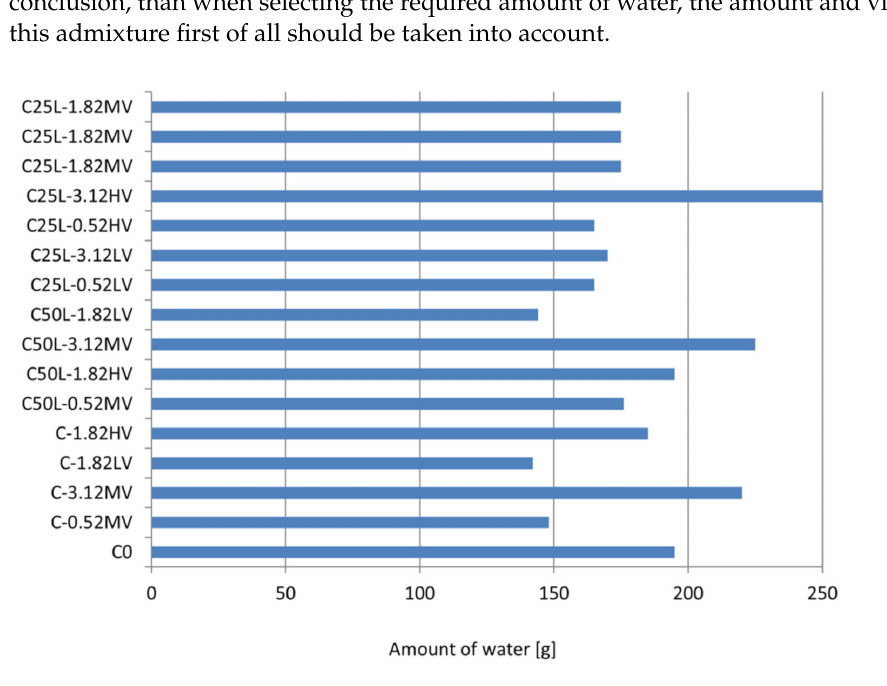
Figure 2. Amount of water in